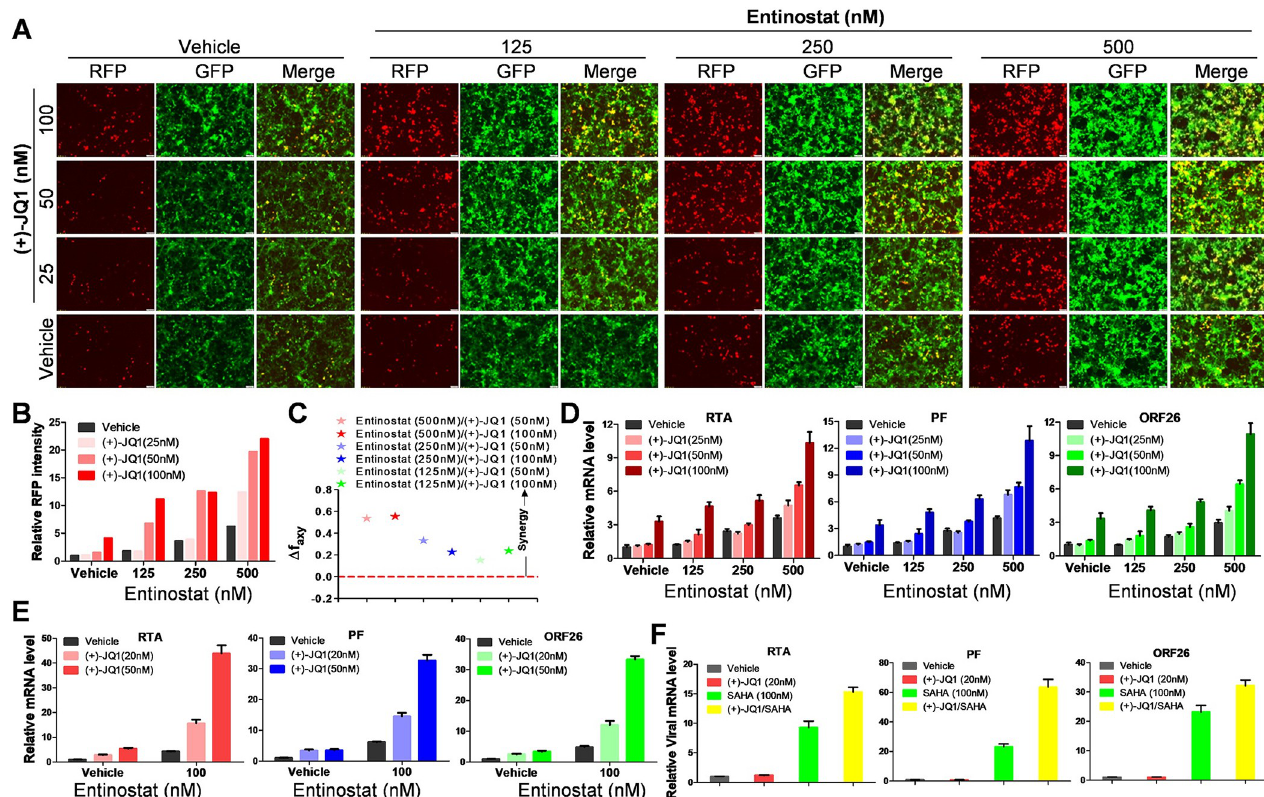
Fig 1. The synergistic viral lytic-inducing effect of dual inhibition of HDACs/BRD4. The iSLK.219 cells were exposed to compound combinations with low dose of Dox addition (0.05 μ g/mL) for 48 h, then RFP expression was detected using fluorescence microscopy ( A ), and the fluorescence intensity was quantified using the software CellSens Ver.2.2. ( B ). The calculation of synergy for drug combination was analyzed by the Bliss independence model as described in the Methods ( C ). Synergy is defined as Δ fa xy > 0 while Δ fa xy = or < 0 indicates additive effect or antagonism. The expression of viral lytic genes was measured by RT- qPCR ( D ). Data was normalized as the fold change compared to the Dox control. BCBL-1 cells were exposed to a combination of entinostat /(+)-JQ1 ( E ) or SAHA/(+)-JQ1 ( F ) for 48 h, then the expression of lytic genes was measured by RT-qPCR. Data was normalized as the fold change compared to the DMSO